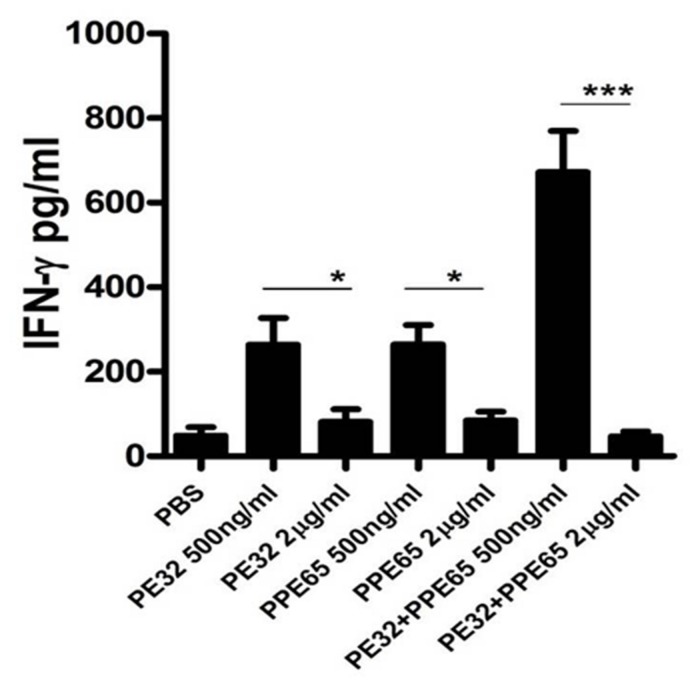
PE32 and PPE65 proteins reduce the secretion of IFN-γ in splenocytes of mice immunized with respective proteins. Splenocytes isolated from mice which were immunized with PE32, PPE65, and PE32 + PPE65 proteins were again challenged with corresponding proteins in culture for 72 h, supernatants were harvested and sandwich ELISA for IFNγ was performed. Note the decrease in IFNγ level with increase in protein concentration. Experiments were performed at least twice; SEM is represented by error bar for biological triplicates. ∗p < 0.05, ∗∗∗p < 0.001.